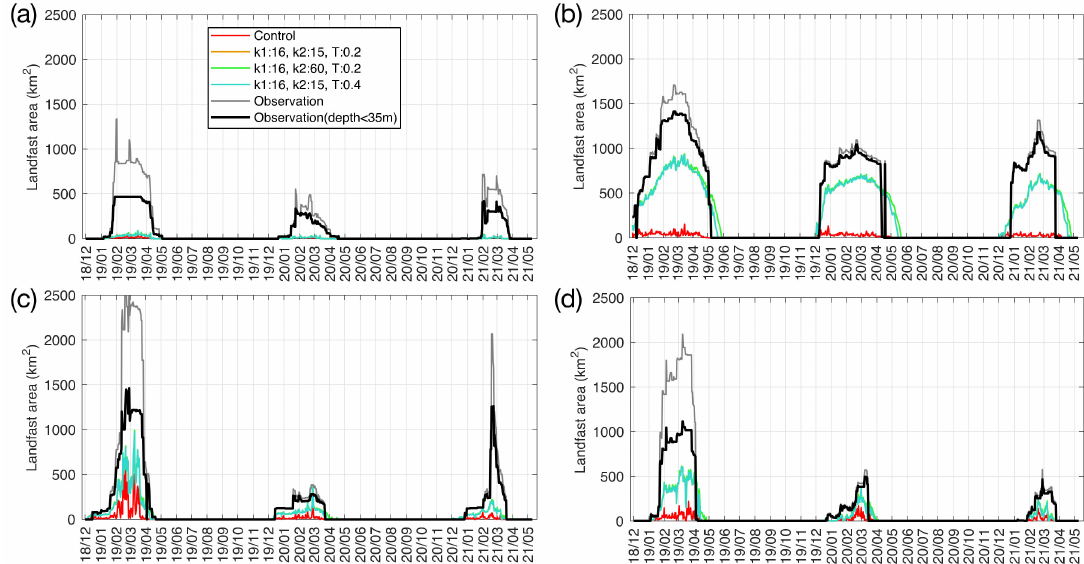
Figure 5. Time-series of the landfast ice area from model results and NIC observations for of the 4 domains in Figure 4a. The panels ( a – d ) correspond to these domains. The model output presents the results of the sensitivity experiments with k 1 = 16, k 2 values varying from 16 to 60 Nm − 3 , and tensile strength ( T ) varying from 0.2 to 0.4. The gray line indicates the total landfast ice area obtained from NIC observations and the black line indicates the landfast ice area limited to water depths shallower than 35 m.